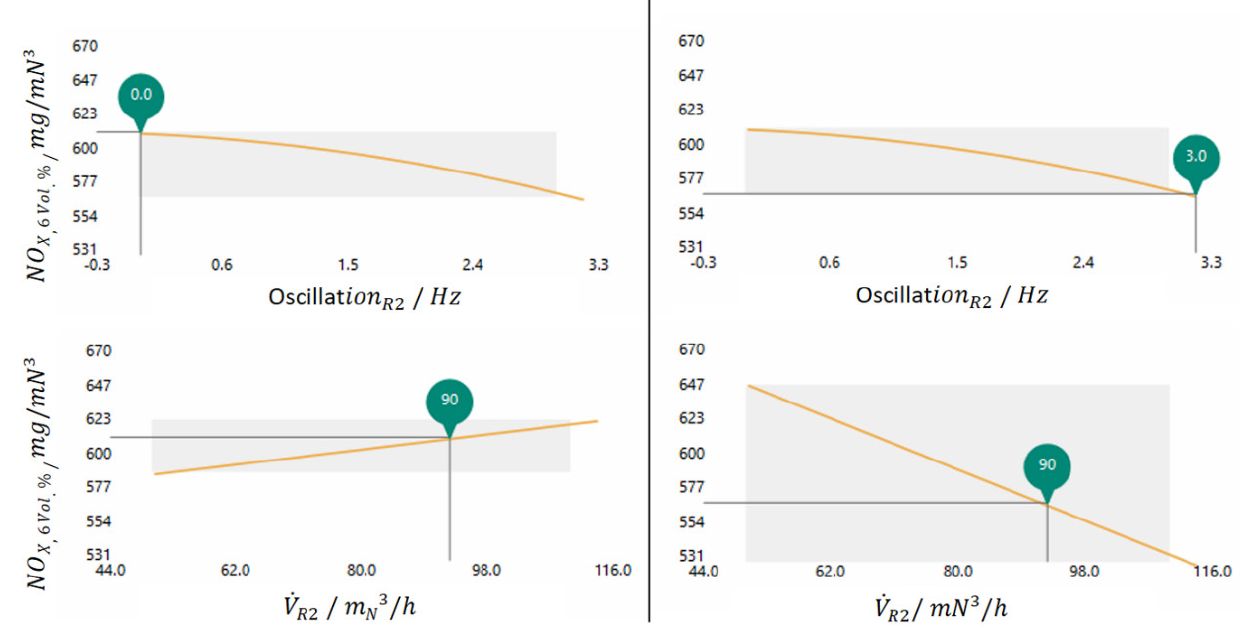
Figure 7. Results of the Interaction in R2.